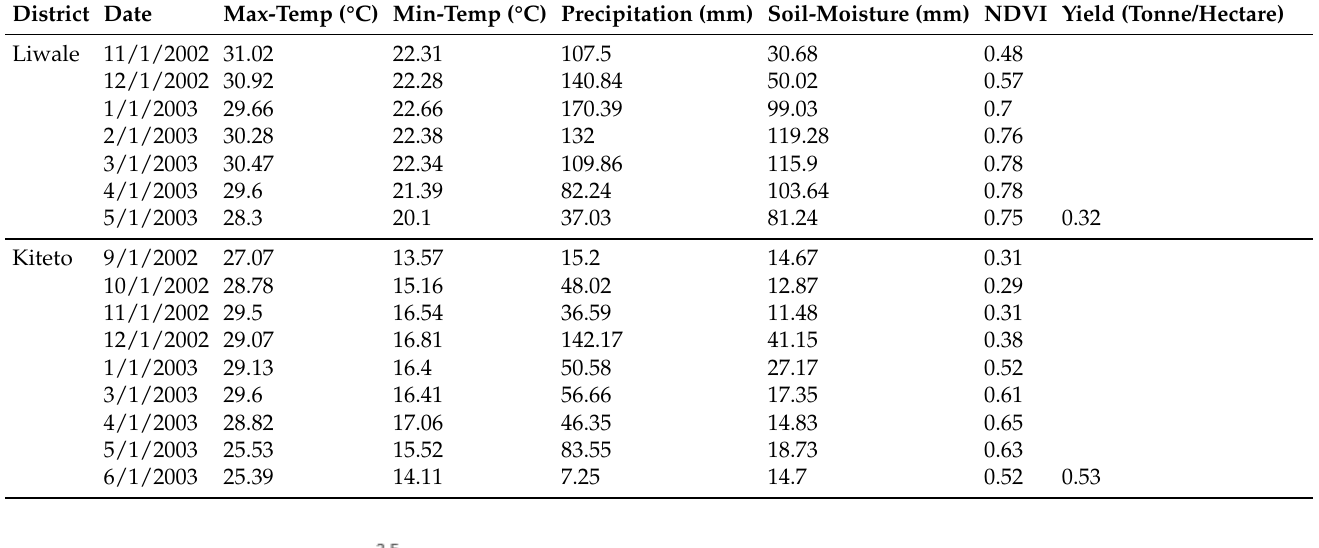
Table 2. Liwale and Kiteto district single data points for 2002/2003 maize season.